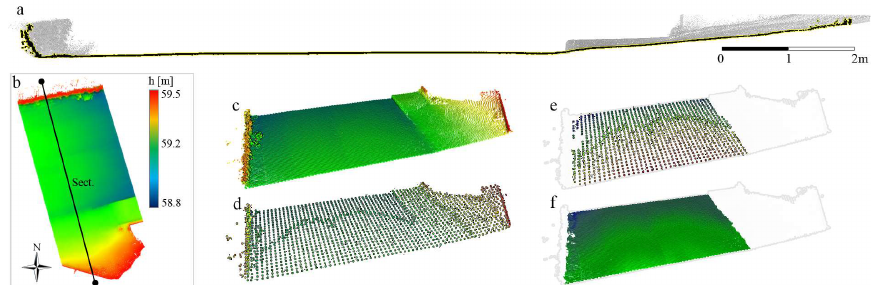
Figure 10. Down-sampling run for a box. (a) Original point cloud, profile view along the section traced on the (b). Plan view. (c) Original point cloud. (d) Voxel grid. (e) Voxel grid after filtering. (f) Final output (filtered point cloud). Remote Sens. 2020 , 12 , x FOR PEER REVIEW